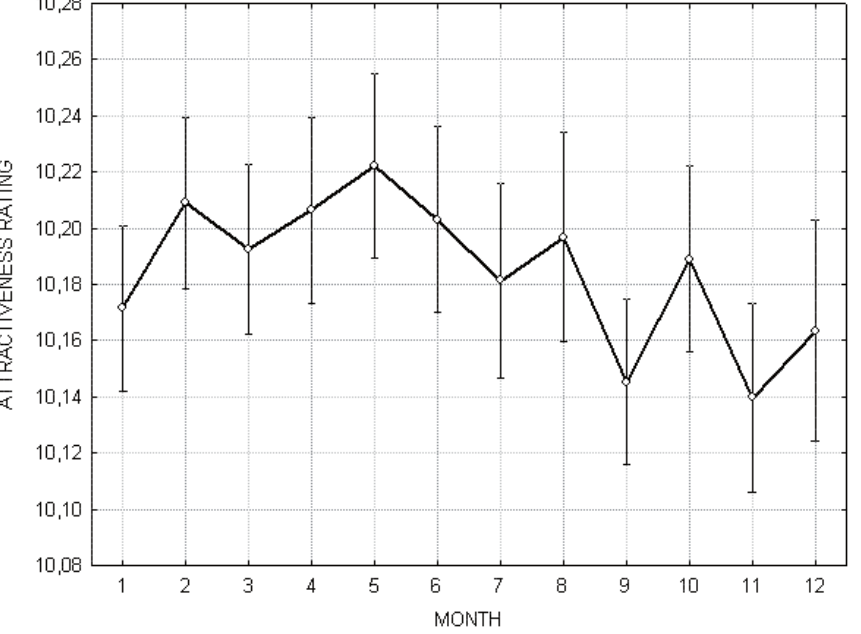
Figure 1. Effect of the month of birth on physical